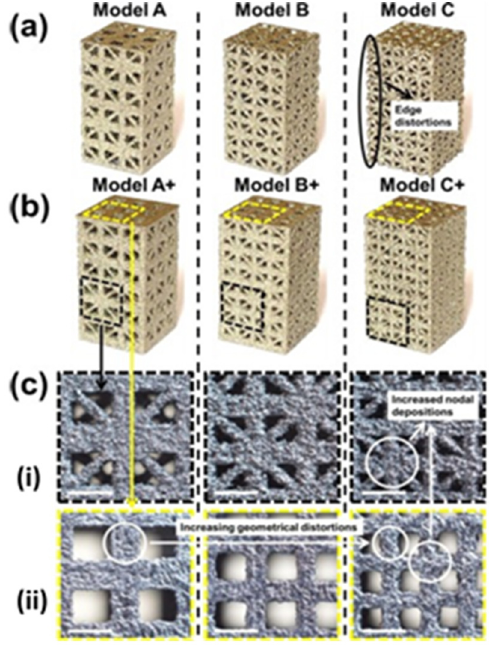
Figure 31. Digital images of three different micro-lattice designs ( a ) with and ( b ) without solid outer supports on the edges. The unit-cells of Models A to C are progressively smaller in size, with cell lengths ranging from 3.33 mm to 2 mm. The supports for models A+ to C+ also range in thicknesses from 670 μ m to 400 μ m. Sub-figure ( c ) shows magnified sections of the models displayed in ( a , b ), with focus on the smaller ( c )—( i ) and larger ( c )—( ii ) pore structures. Here, the scale bar is 3 mm [152]. (Reprinted from Additive Manufacturing, Volume 36, P. Wang, et al., ‘Electron beam melted heterogeneously porous microlattices for metallic bone applications: Design and investigations of boundary and edge effects’, Copyright (2020), with permission from Elsevier).